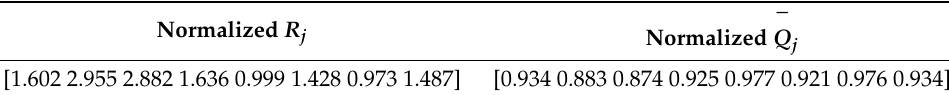
Table 2. Normalized internal resistances and capacities for the 8S module.